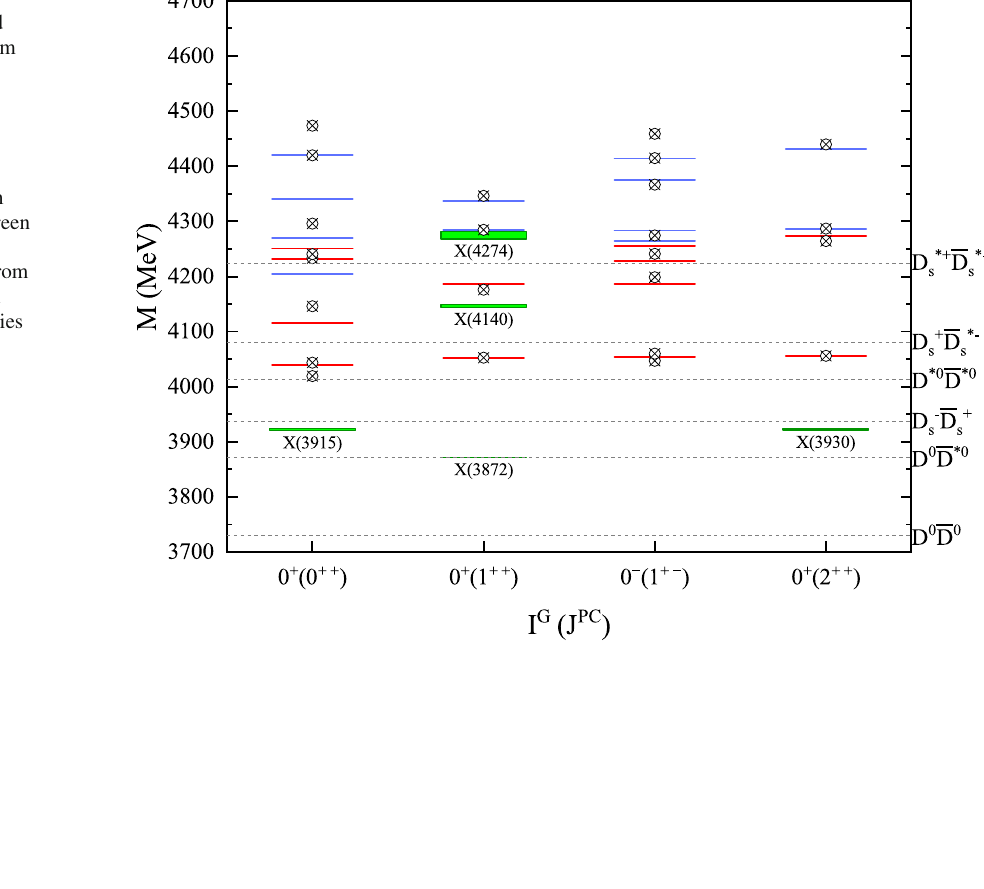
Fig. 1 Mass spectrum of ground S -wave X states. Red solid lines denote cn ¯ c ¯ n system and blue lines denote cs ¯ c ¯ s system, hollow circles with crosses denote results after considering cn ¯ c ¯ n and cs ¯ c ¯ s mixing, gray dotted lines are corresponding S -wave charm meson pair thresholds, the green rectangles represent X states experimental masses taken from PDG [1], the rectangle width stand their masses